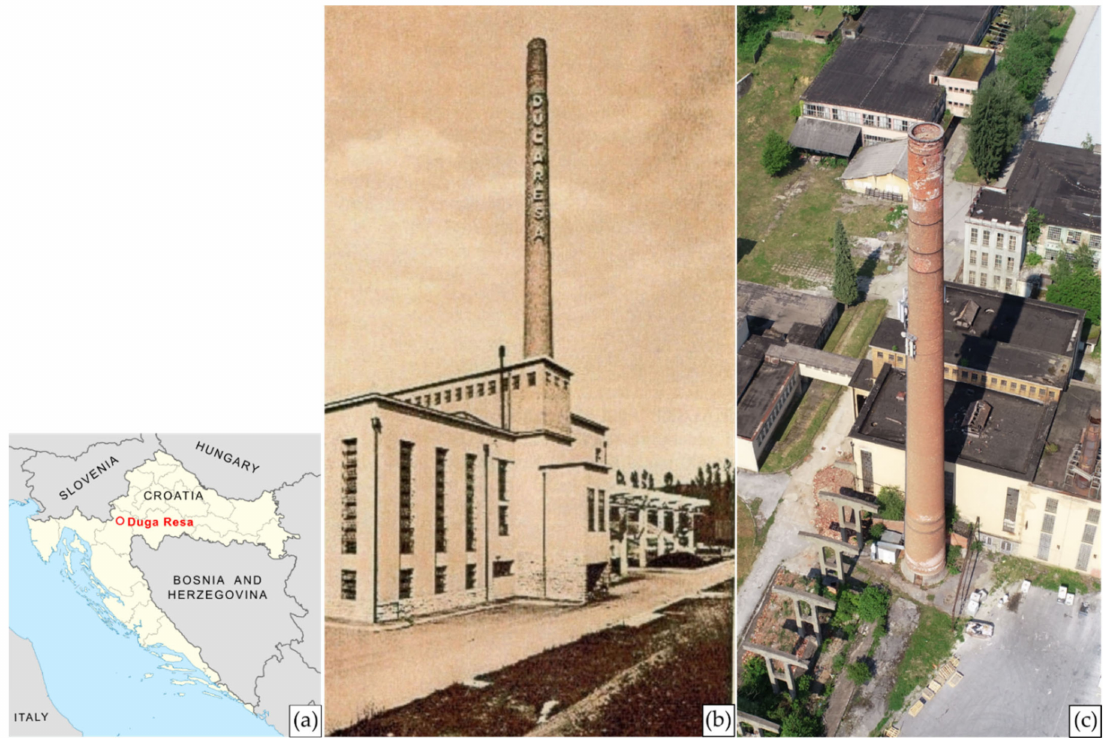
Figure 1. ( a ) Location of the studied industrial chimney with ( b ) its historical depiction [28] and ( c ) a present-day aerial view. The masonry chimney was constructed in 1930 in the form of a truncated cone with a bottom and top diameter of approx. 5.5 and 3.0 m. At its construction, the chimney was circa 75 m high, but due to its shortening in 1982, today it is roughly 65 m in height